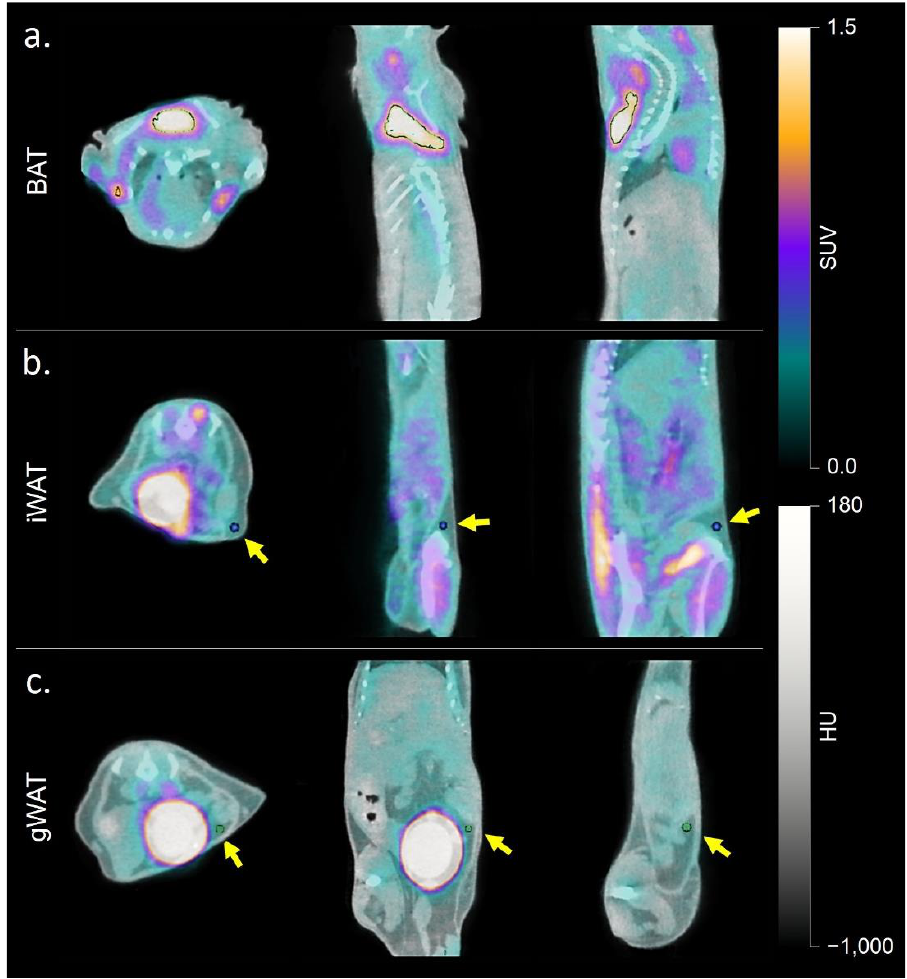
Figure 7. Examples of ROIs on an 18 FDG-PET/CT in ( a ) classical interscapular BAT, ( b ) inguinal WAT, and ( c ) gonadal WAT. Yellow arrows indicate spherical ROIs positioned within the iWAT and gWAT depots in ( b , c ).